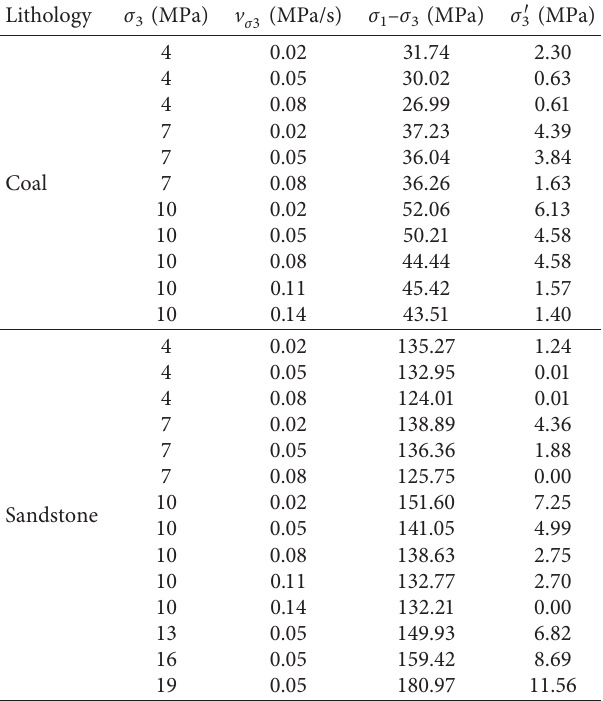
Table 3: Results of triaxial unloading confining pressure tests.